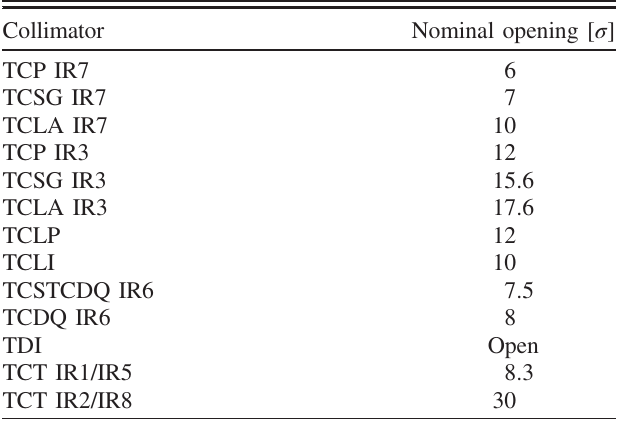
TABLE III. The collimator settings used in the CC study for the